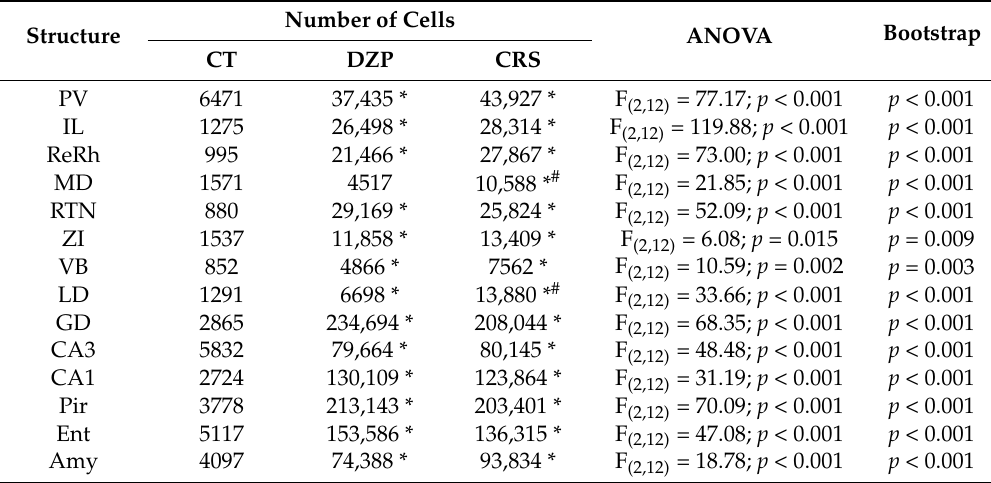
Table 2. Quantification of c-Fos positive cells in CT, DZP and CRS rats.